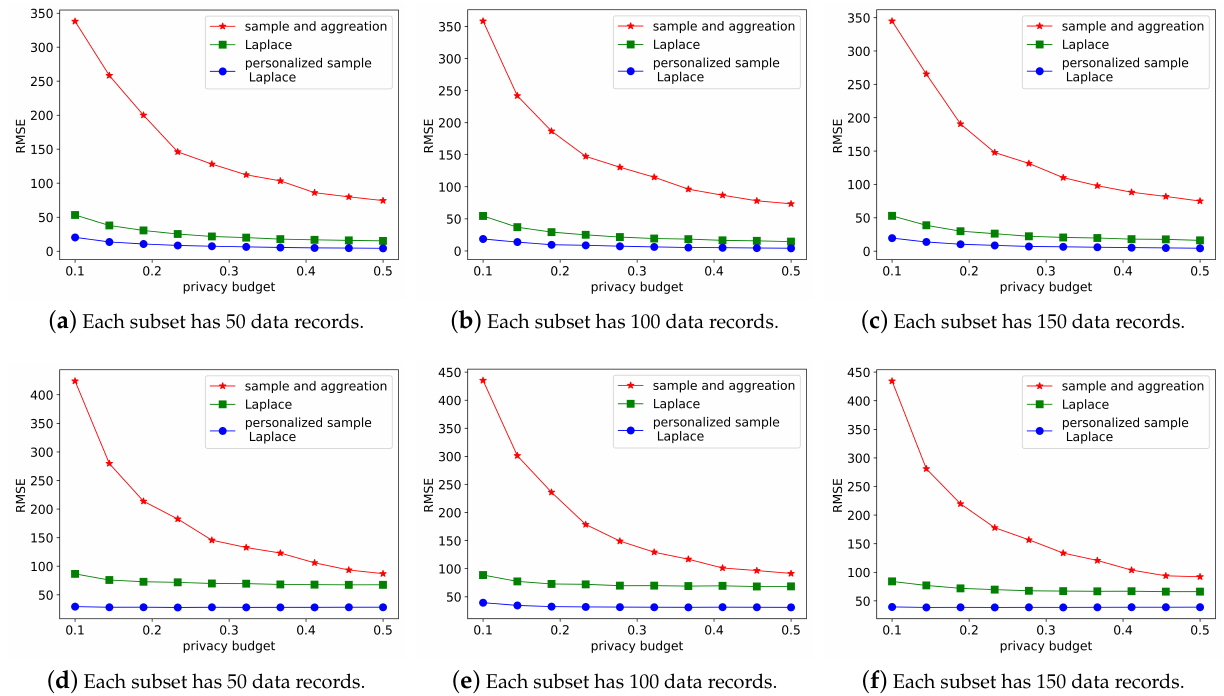
Figure 5. The influences of the number of records in each